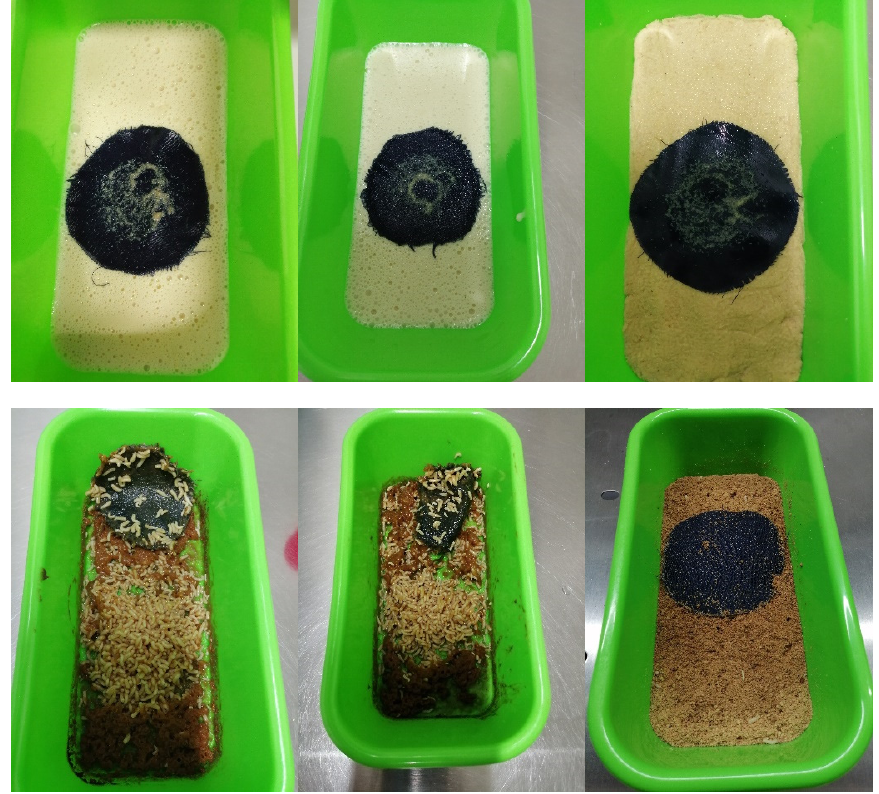
Figure A1. From left to right: gel ‐ agar, gel ‐ carrageenan and mass ‐ rearing diets tested in Experiment 3. The top row shows the diets on the day of their preparation and inoculation with A. ludens hatching eggs; the bottom row shows the same diets after nine days. Note the relatively high amount of diet waste in the mass ‐ rearing diet compared to the gel diets.